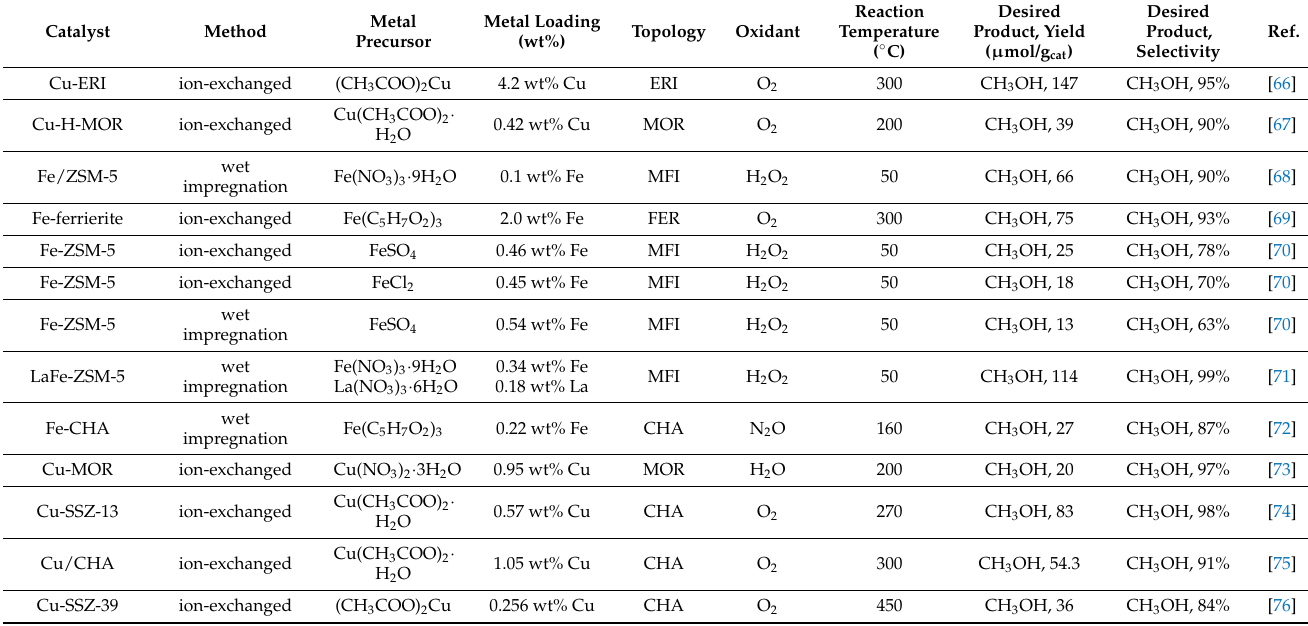
Table 2. Summary of operation conditions and catalytic activities of the typical zeolite-based catalysts for the selective oxidation of